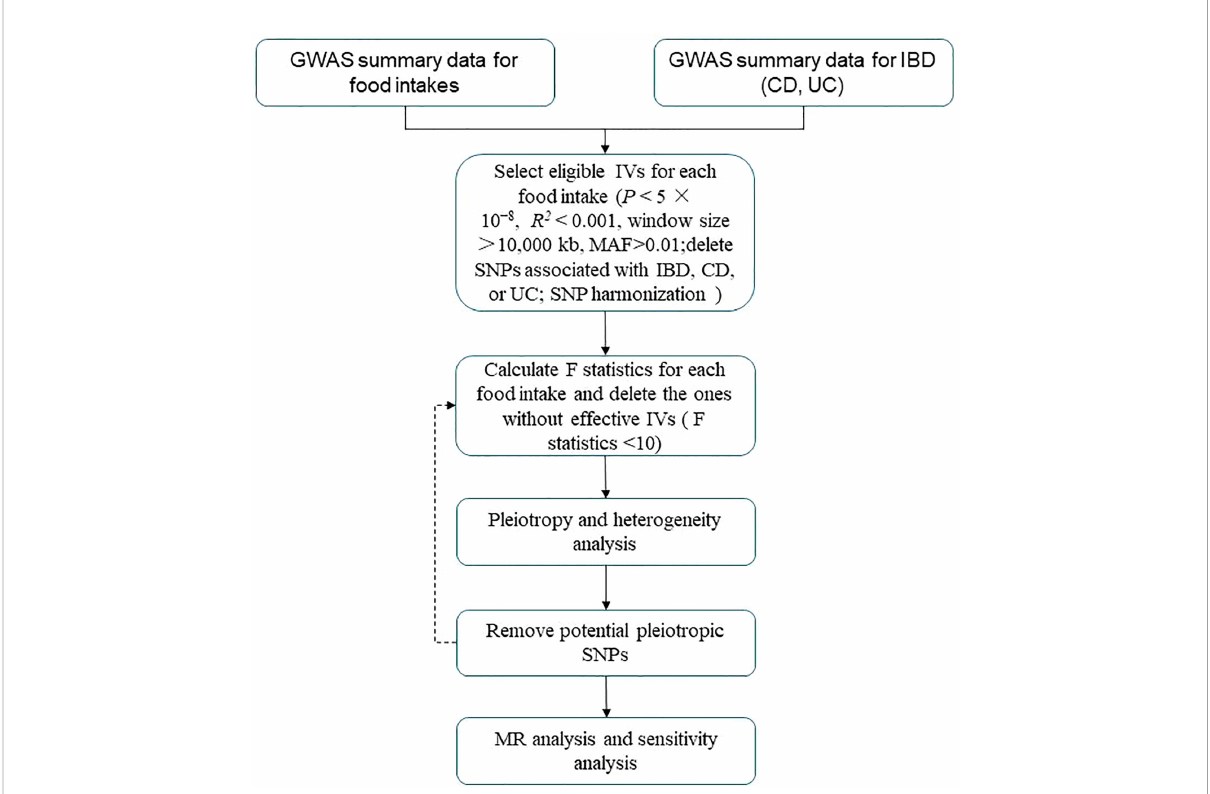
FIGURE 1 Flowchart of MR analysis in this study. IBD, in fl ammatory bowel disease; CD, Crohn ’ s disease; UC, ulcerative colitis; MAF, minor allele frequency; IVs, instrumental variables; SNPs, single-nucleotide polymorphisms; MR analysis, Mendelian randomization